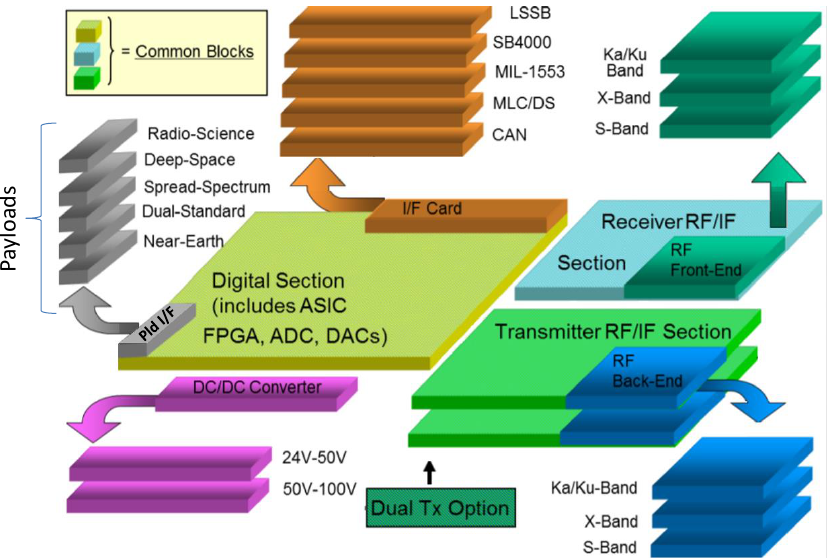
Figure 3. TAS-I transponder platform